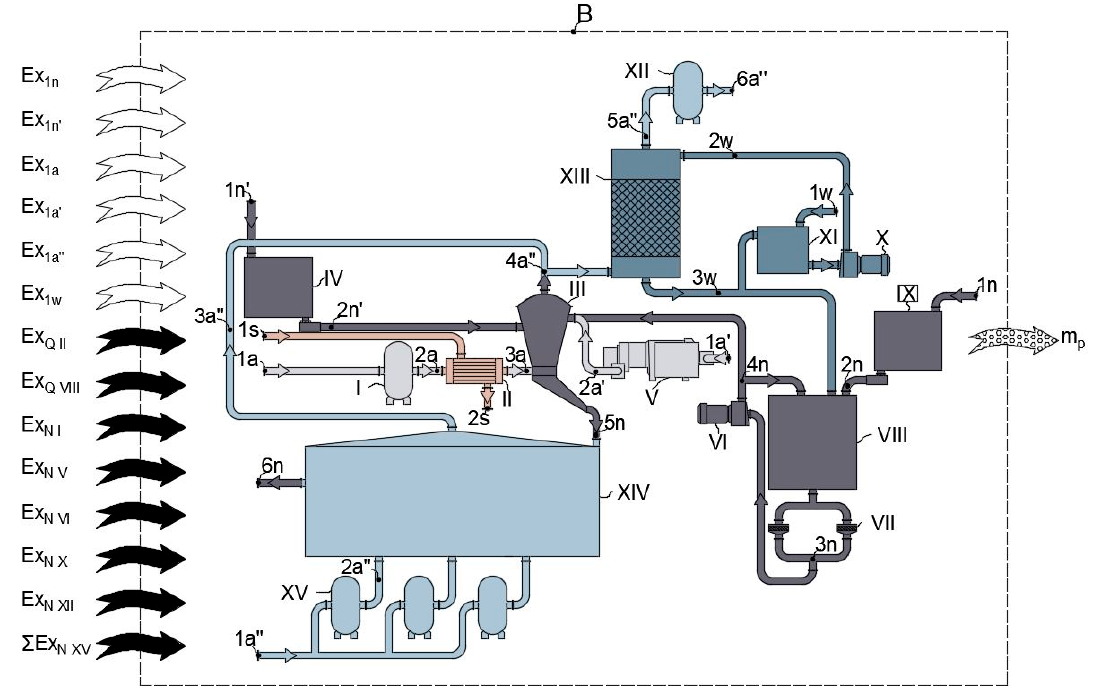
Figure 1. Considered exergy contour B of the basic technological scheme of porous ammonium nitrate granulation. I—gas